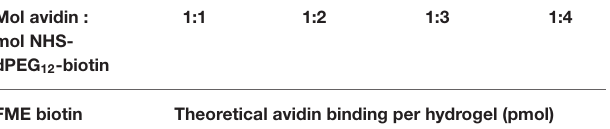
TABLE 1 | Theoretical avidin binding in biotinylated gelatin hydrogels, assuming 1:1, 1:2, 1:3, and 1:4 avidin to biotin binding. Mol avidin : mol